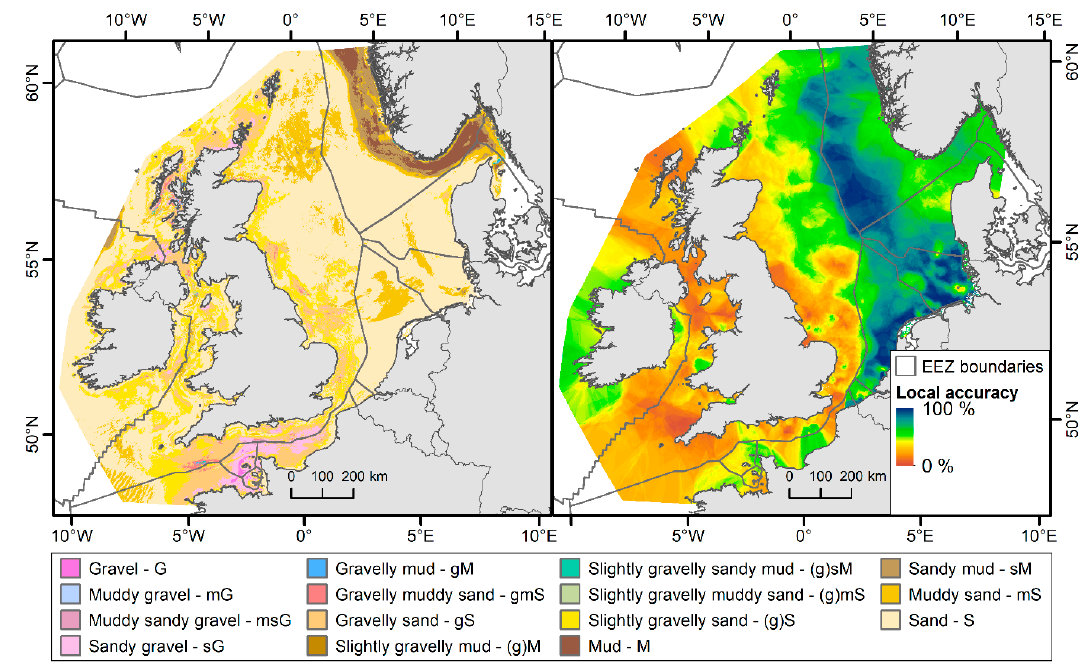
Figure 9. Predicted sediment class based on Folk 16 sediment class definitions and the spatial distribution of accuracy.